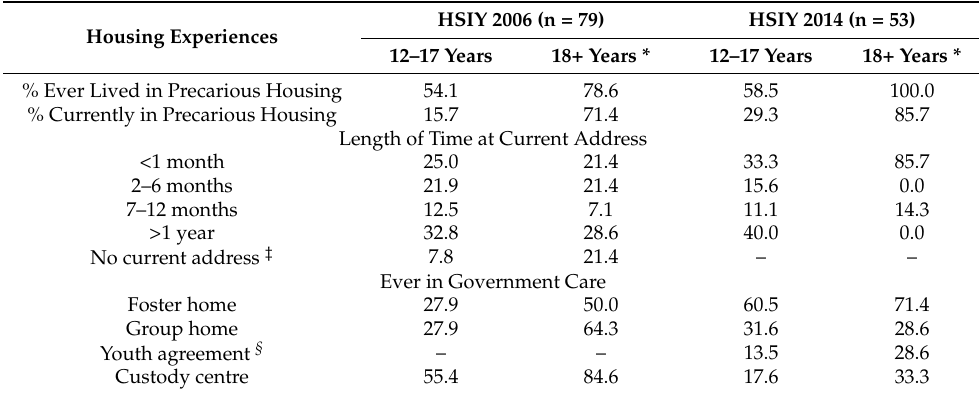
Table 2. Participant housing situation of sexually exploited